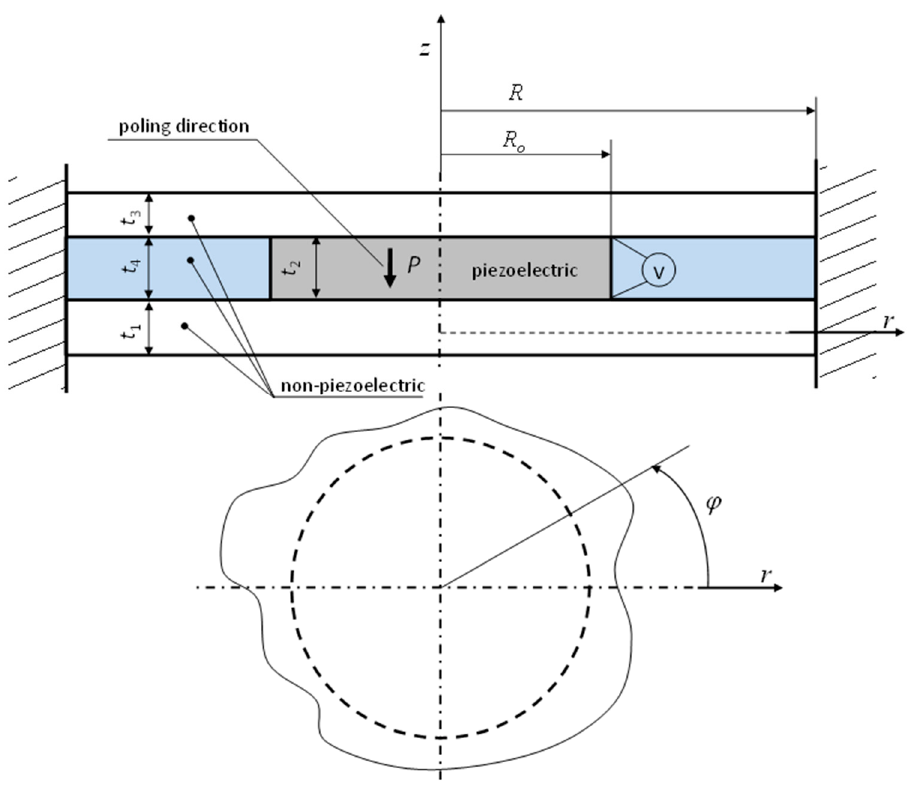
Figure 1. The structure schematic of the three-layer circular piezoelectric transducer.